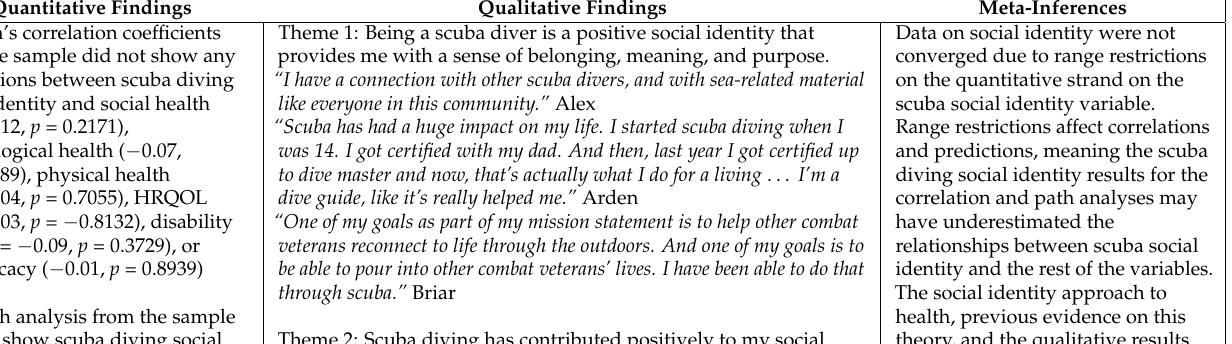
Table 9. Joint display with mixed methods results on the relationships between scuba diving social identity, self-efficacy, social health, psychological health, physical health, HRQOL, and disability level among people with physical